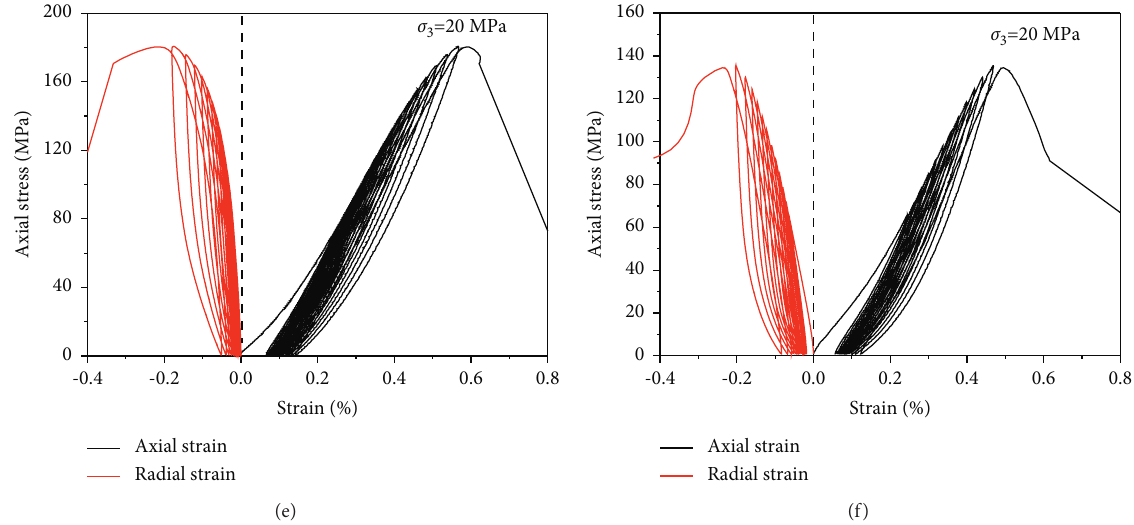
Figure 2: Stress-strain curves of phyllite under triaxial cyclic loading ( σ 3 is the confining pressure). (a) Dry sample. (b) Saturated sample. (c) Dry sample. (d) Saturated sample. (e) Dry sample. (f) Saturated sample.